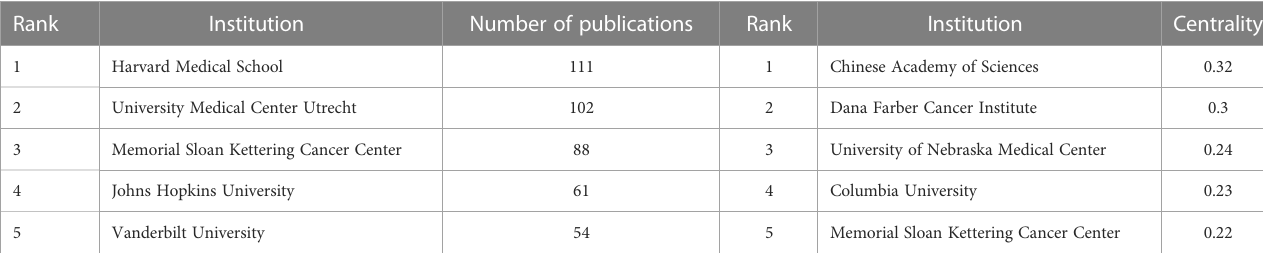
TABLE 3 Centrality rankings and number of publications of the top fi ve institutions in the fi eld of tumor organoid research. Rank